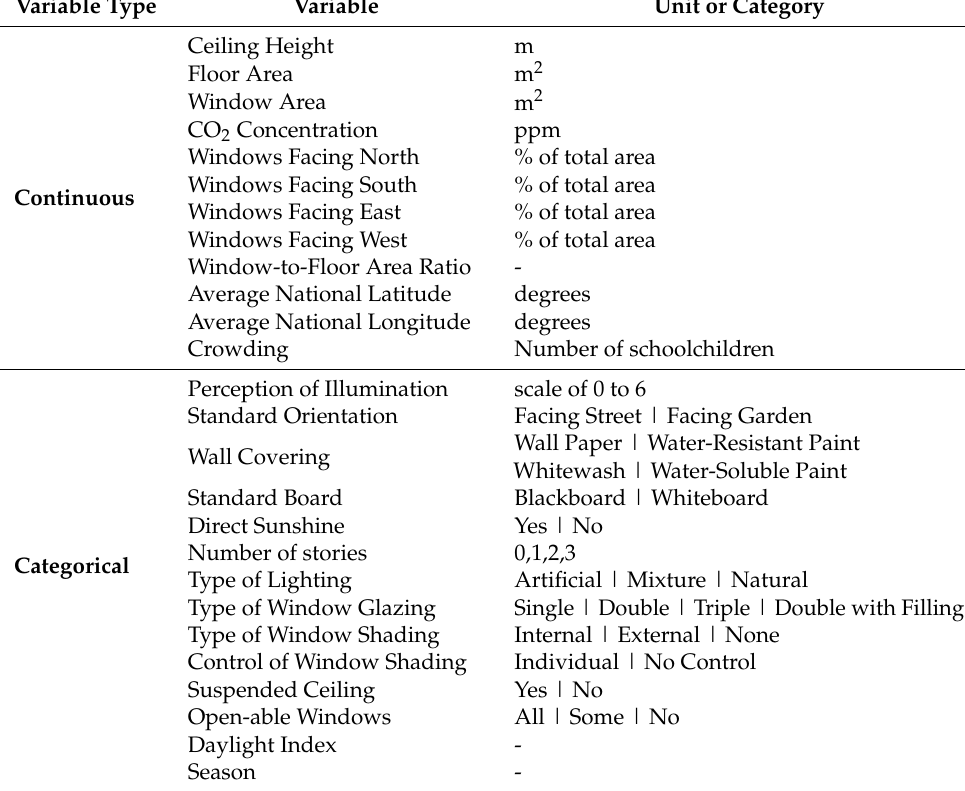
Table 1. Collected data relevant to